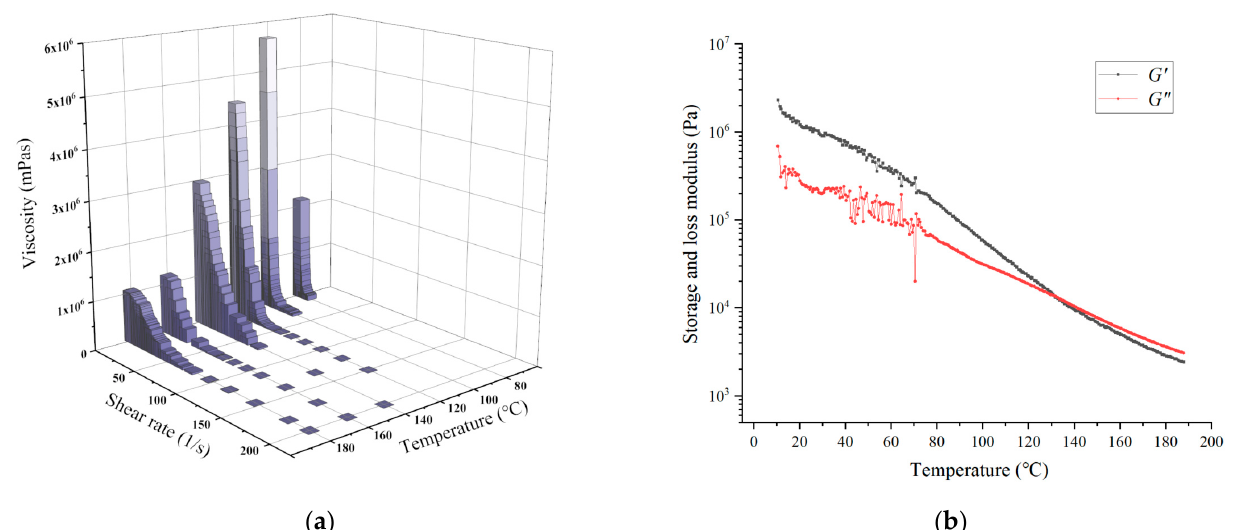
Figure 4. The rheological properties of PLCL: ( a ) viscosities of PLCL with varying temperatures and shear rates; ( b ) complex modulus curves of PLCL with varying temperatures.